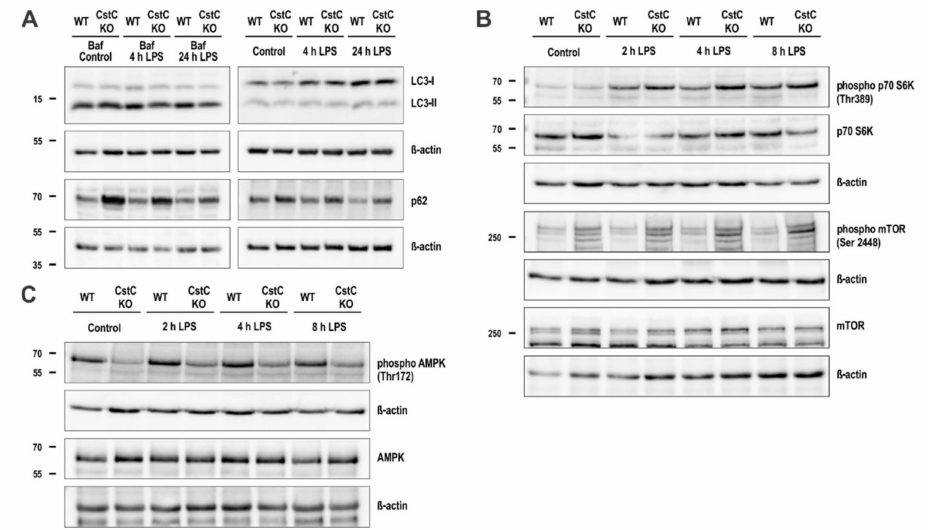
Figure 6. Decreased autophagy induction in CstC KO BMDMs. ( A ) BMDMs were pretreated with Bafilomycin A1 (80 nM) for 1 h, as indicated, and stimulated with LPS (100 ng/mL) for 4 or 24 h. ( B ) and ( C ) BMDMs were stimulated with LPS (100 ng/mL) for the indicated times. Cell lysates were immunoblotted with indicated antibodies. Data shown are cropped blot images representative of three independent